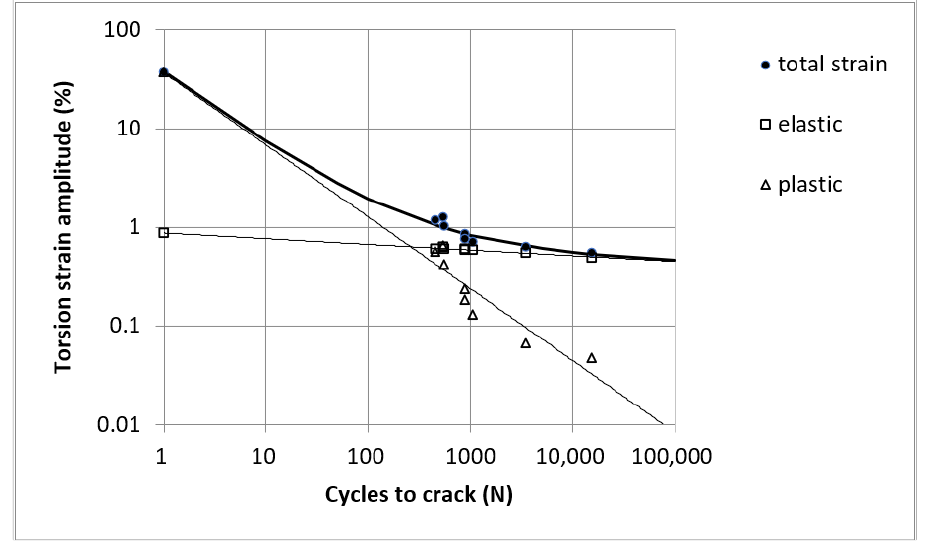
Figure 8. Dynamic shear stress–strain diagram for AlMgSi1.